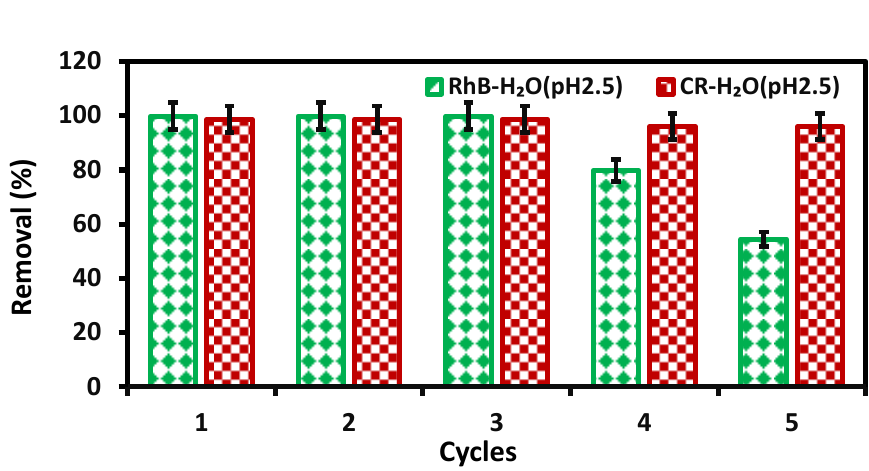
Figure 10. Regeneration cycle of PTFAC after adsorption by RhB and CR dyes. Table 4. Desorption percentage of CR and RhB dyes by PTFAC with different desorption reagents.